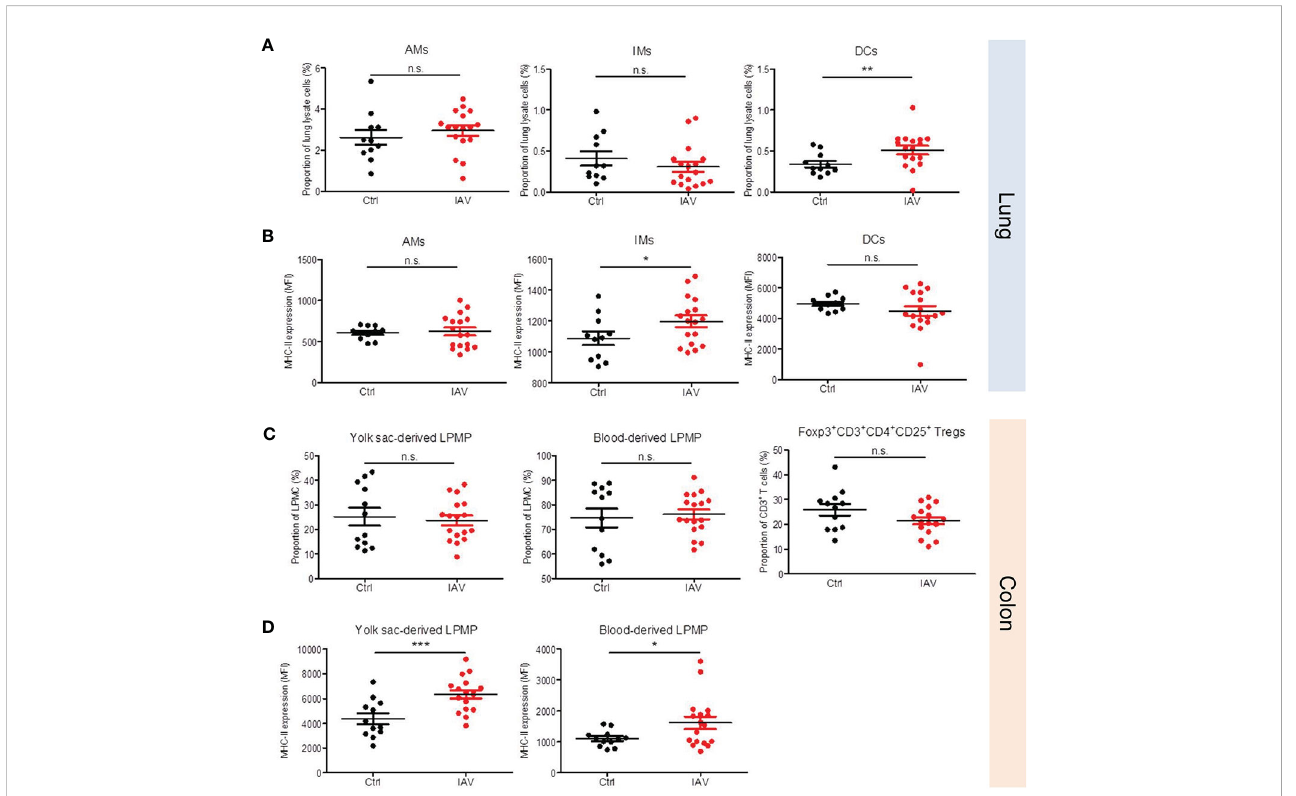
FIGURE 5 Neonatal exposure to IAV induces long-lasting changes in the phenotype of lung and gut resident leukocytes. Single-cell suspensions of (A, B) the lungs and (C, D) the colonic lamina propria from d21 mice pretreated i.n. with PBS (Ctrl, n = 11-12) or 5 PFU of IAV (n = 17) on d3 of life. (A, C) Numbers and (B, D) MHC-II expression (MFI, mean fl uorescence intensity) of indicated leukocytes in lungs and colons. Bars represent means ± SEM. *p < 0.05, **p < 0.01, ***p < 0.005 (MWU test). n.s., not signi fi cant. AM, alveolar macrophage; DC, dendritic cell; IM, interstitial monocyte; LPMP, lamina propria macrophage; Tregs, regulatory T